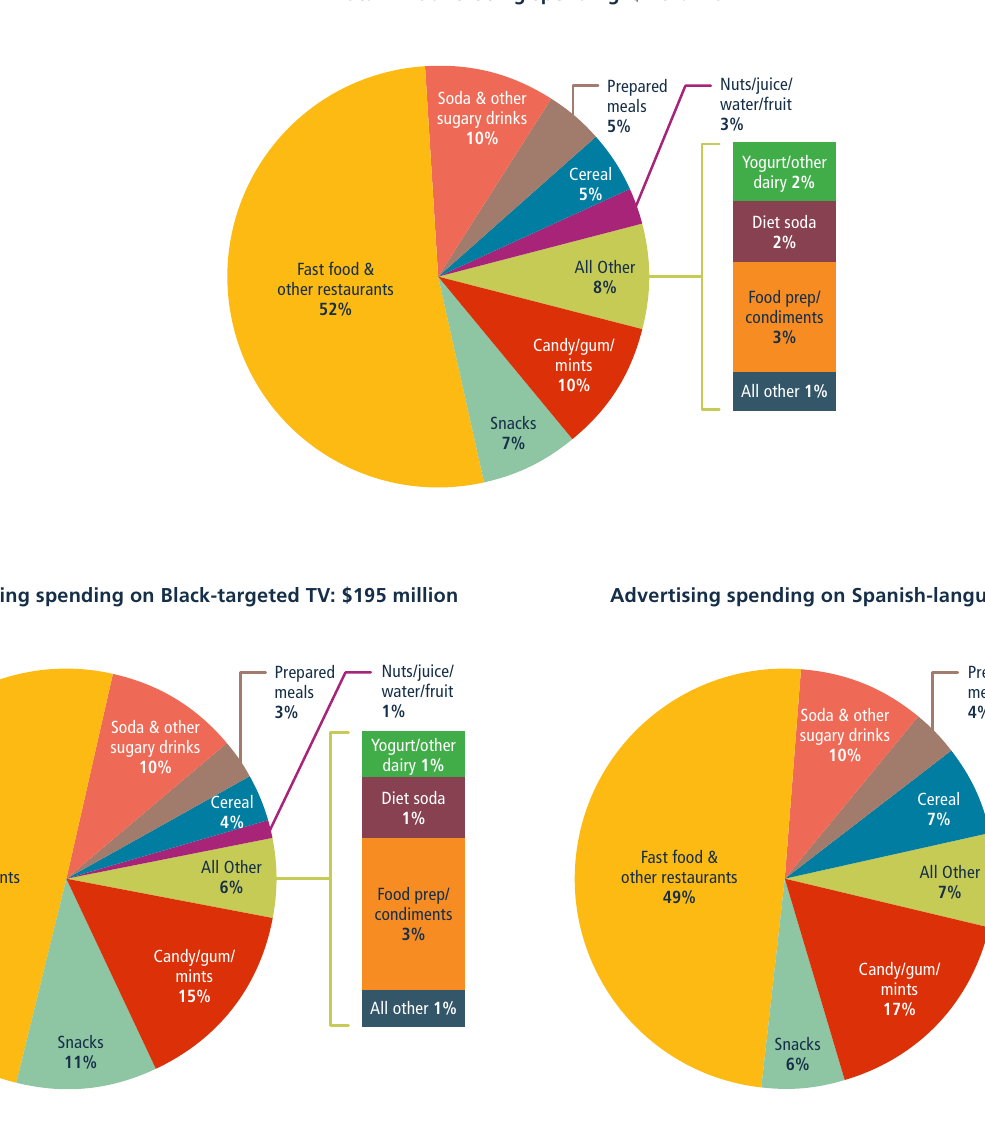
FIGURE 15. PROPORTION OF TV ADVERTISING SPENDING BY CATEGORY*